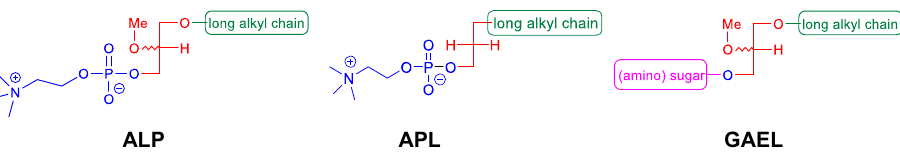
Figure 1. Different classes of antitumor ether lipids (AELs); alkyllysophospholipids (ALP), alkylphospholipids (APL), and glycosylated antitumor ether lipids (GAEL). 2. GAELs: How Did We Get Here?